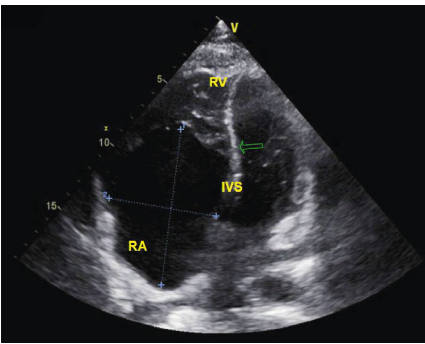
Figure 4: Apical 4 view showing apical displacement of the tri- cuspid valve leaflet causing atrialization of the right ventricle. This is diagnostic of Ebstein’s